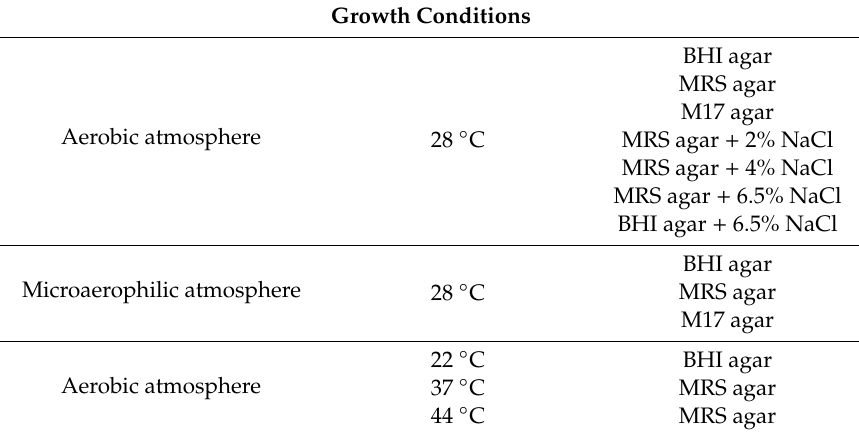
Table 1. Growth conditions used for lactic acid bacteria (LAB) and non-LAB